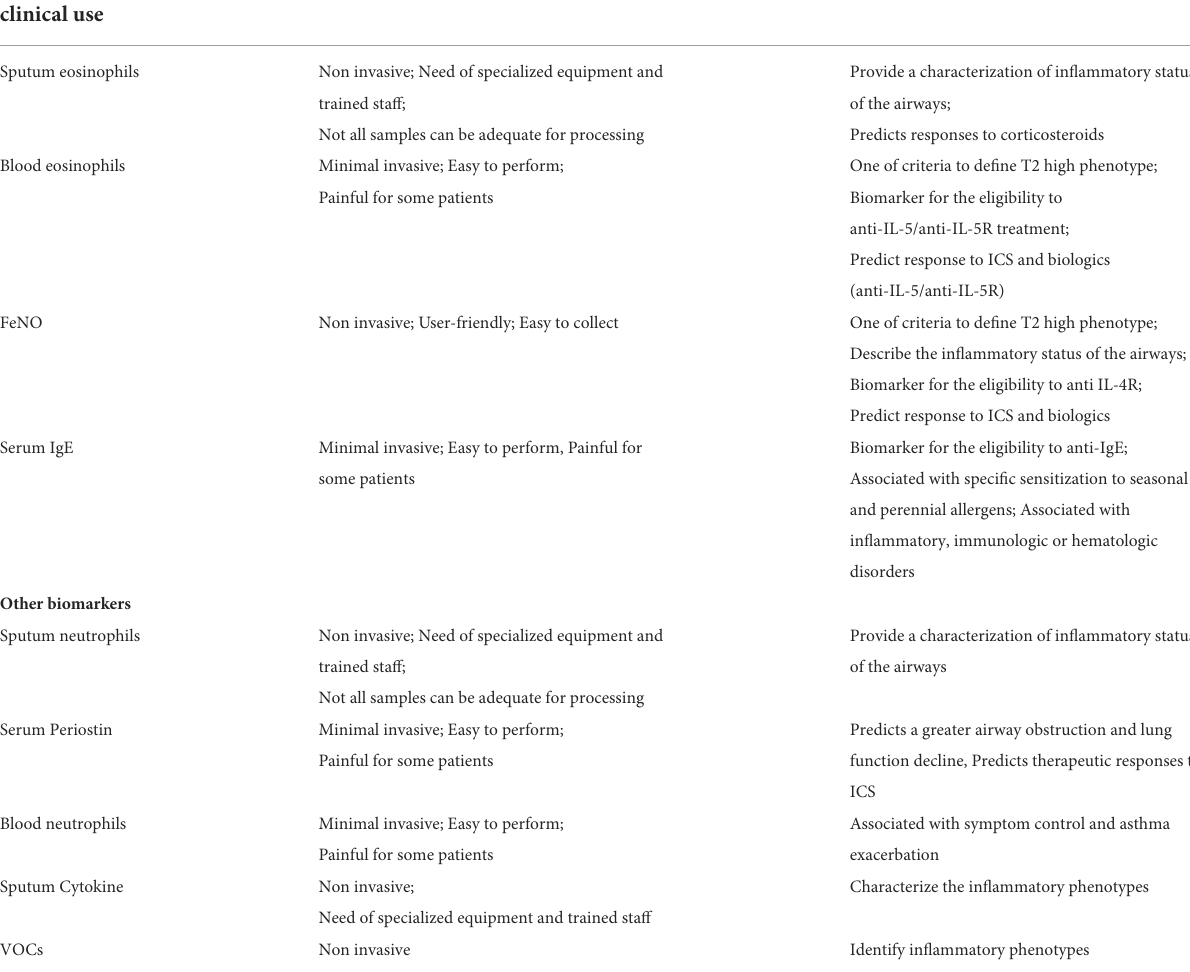
TABLE 7 Summary of asthma current biomarkers’